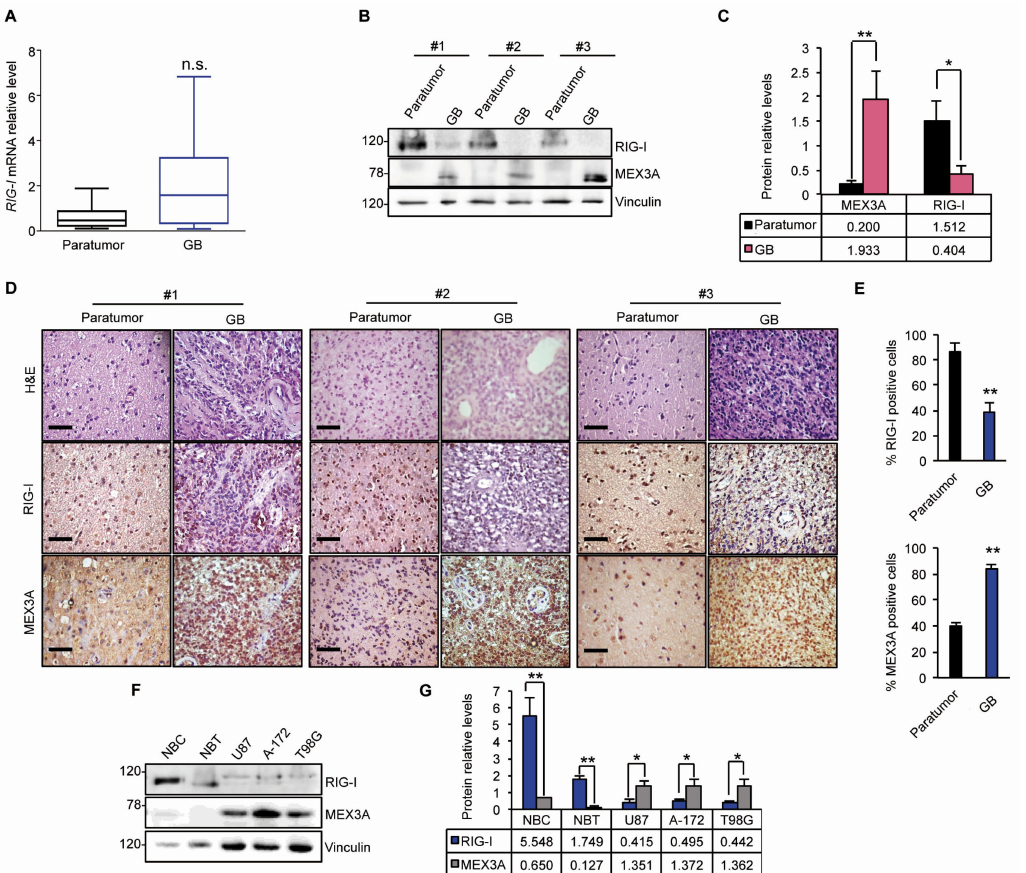
Figure 3. MEX3A up-regulation is associated with low RIG-I protein level in GB. ( A ) qRT-PCR gene expression analysis of RIG-I in GB specimens shown in Table 1. Data were normalized to endogenous GAPDH and HPRT controls. ( B ) Representative immunoblotting analysis of MEX3A and RIG-I proteins levels in three GB and paratumor paired samples. ( C ) Densitometric analysis of actin-normalized of MEX3A and RIG-I protein levels shown in ( B ). ( D ) H&E and immunohistochemical staining of MEX3A and RIG-I of the GB and paratumor samples analyzed in ( B ). Scale bar 100 µ m. ( E ) Quantification of immunohistochemical staining shown in ( D ). ( F ) MEX3A and RIG-I steady state in normal brain tissue (NBT) and normal brain cells (NBC) compared to GB cell lines. ( G ) Densitometric analysis of actin-normalized protein levels assayed in ( F ) represents the mean of three independent experiments. Mean ± SD; * p < 0.05; ** p < 0.01 determined with two-sided Student’s